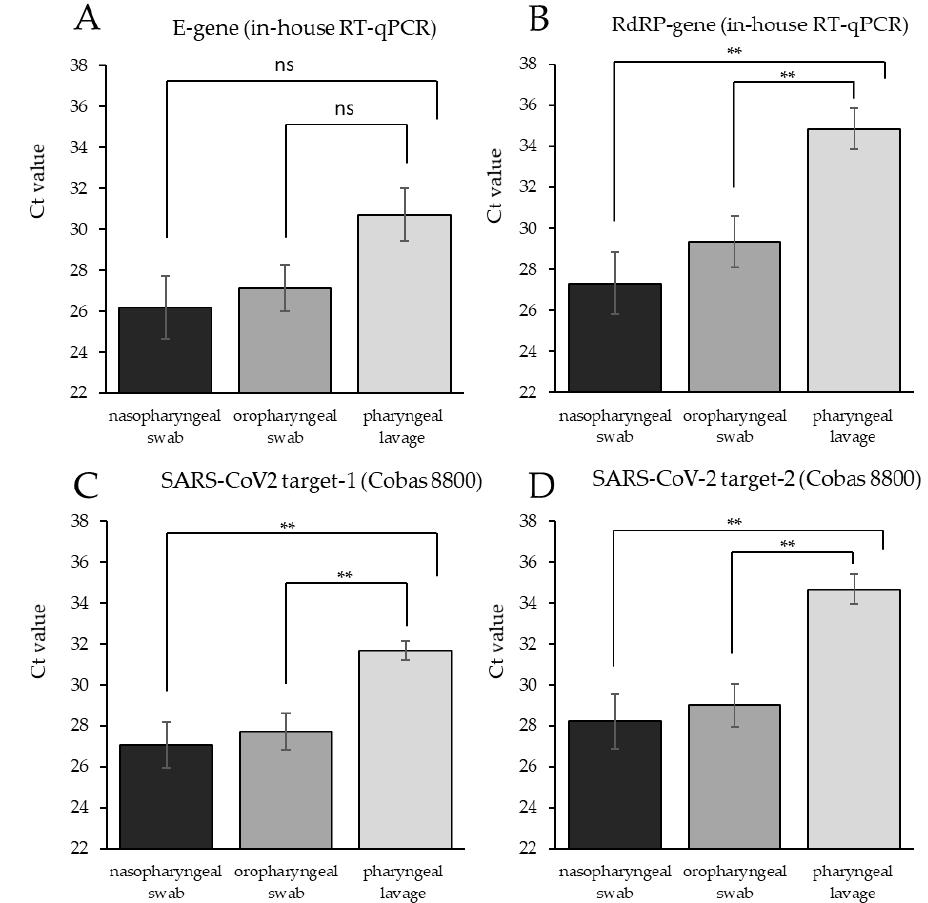
Figure 2. SSB-4M efficiently preserves RNA in naso- and oropharyngeal swab samples, but not in pharyngeal lavage. RNA was isolated from different sample types (naso- or oropharyngeal swabs or pharyngeal lavage). Each sample type was collected from all 16 SARS-CoV-2-positive individuals. In-house RT-qPCR was applied to screen for SARS-CoV-2 E gene ( A ), and the SARS-CoV-2 RdRP gene ( B ). In addition, also Roche Cobas 8800 SARS-CoV-2 target screening was performed ( C , D ). Data shown are mean Ct values +/ − standard deviation of 16 biological replicates for each sample type. ** p < 0.01, ns = not significant.